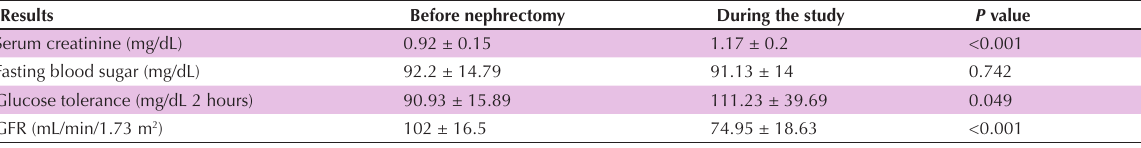
Table 1. Comparison of mean biochemical findings before nephrectomy and during the study